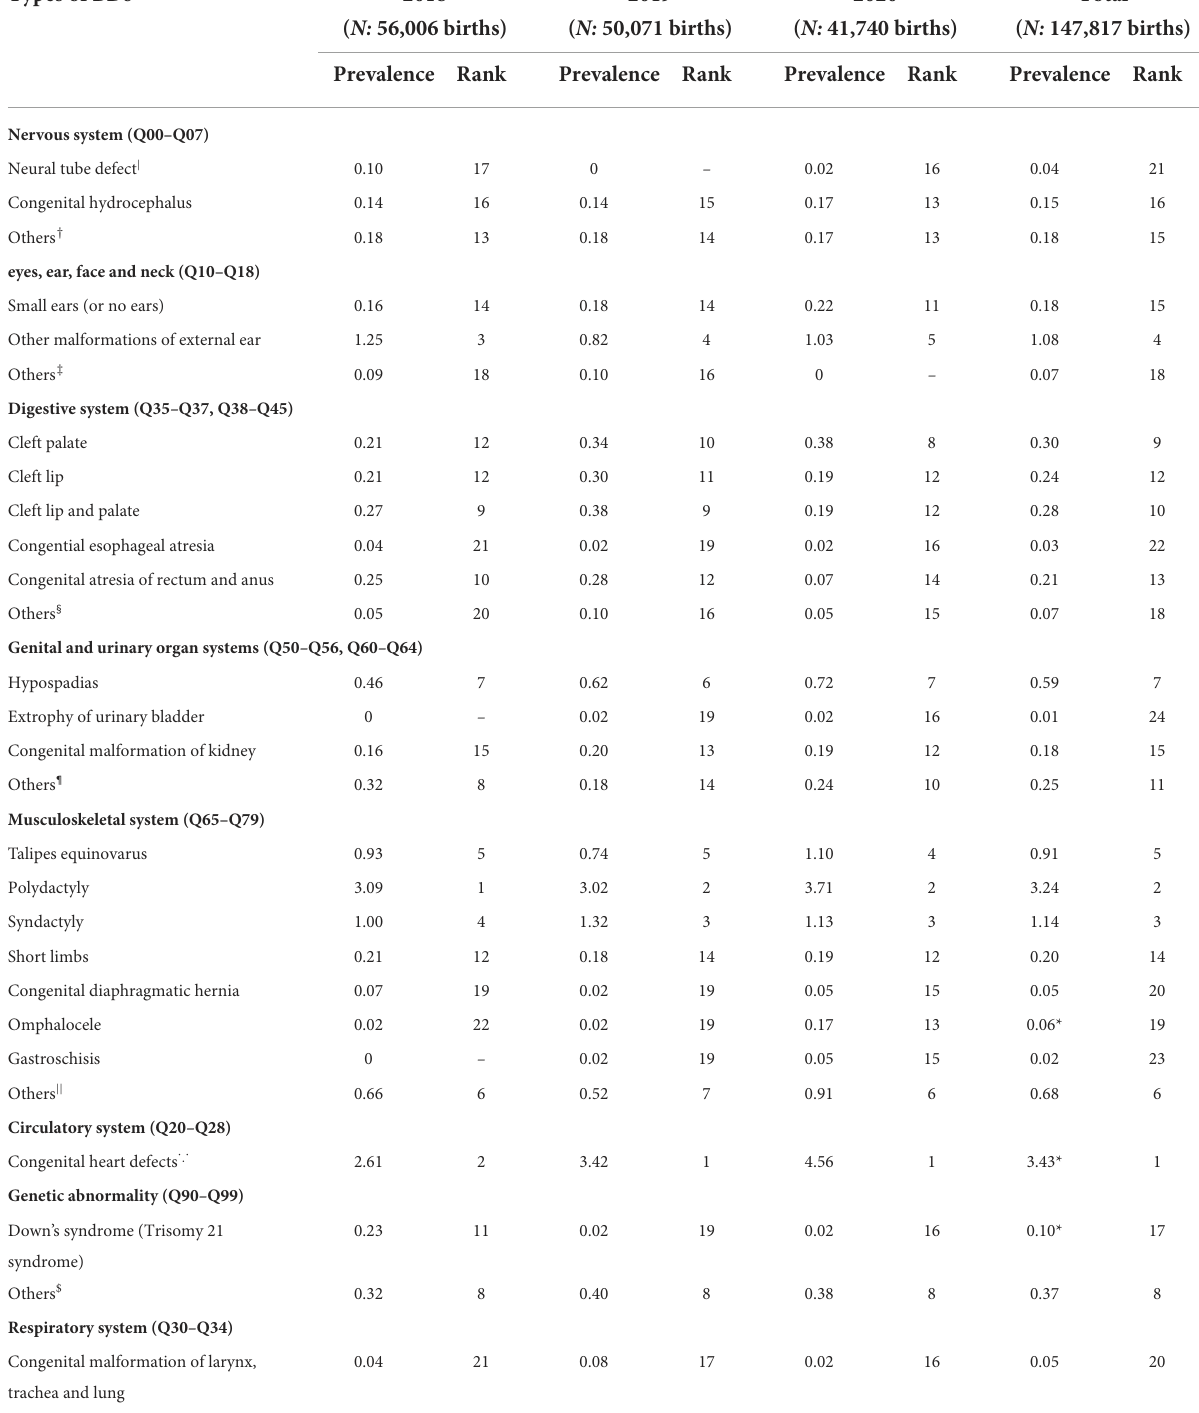
TABLE 2 Prevalence rates of different types of birth defects in Guilin, 2018–2020 (per 1,000 birth). Types of